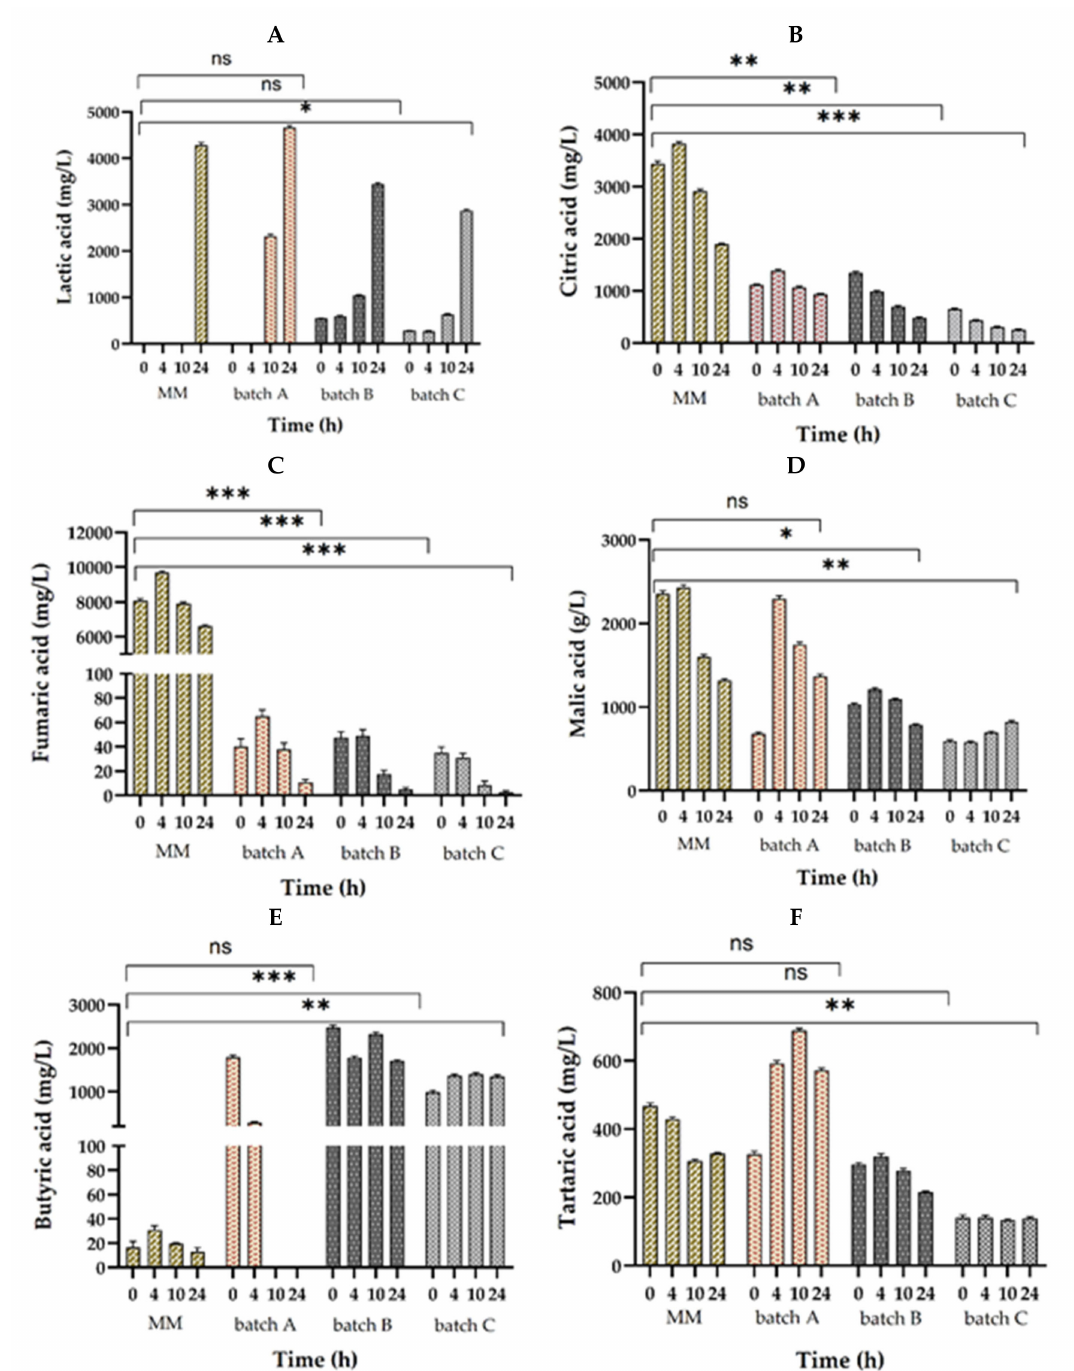
Figure 4. Organic acid production through 24 h fermentation with the cocultures LP and LC in MM (model media—control); batch A (90% WF and 10% SF), B (95% WF and 5% SF), and C (100% WF); ( A ) lactic acid, ( B ) citric acid, ( C ) fumaric acid, ( D ) malic acid, ( E ) butyric acid, and ( F ) tartaric acid. Values displayed as mean ± SD of the triple measurements and symbols (ns, *, **, ***) express the not-significant or significant di ff erences ( p < 0.05) between the MM and the three batches (one-way analysis of variance (ANOVA), multiple comparison